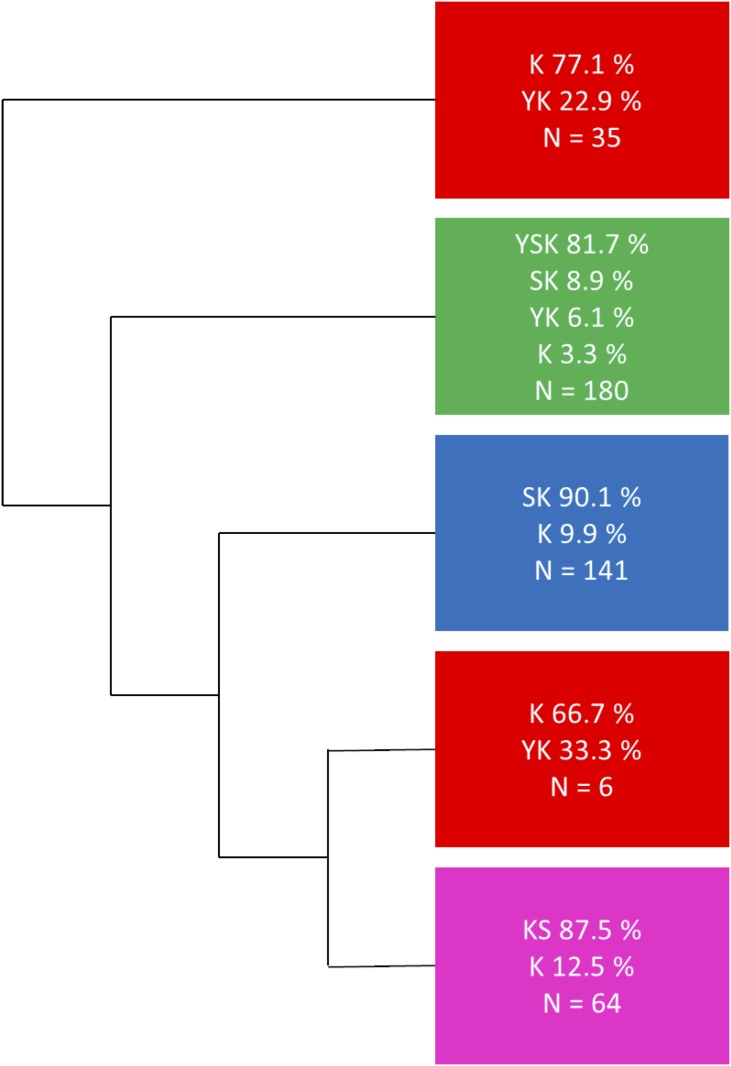
Simplified phylogenetic tree using reannotated sequences showing major dehydrin architecture clusters.The phylogenetic tree in S2 Fig was reduced into clusters by visual inspection in order to minimize the number of clusters while simultaneously trying to generate clusters that were enriched with just one architecture type. The colors represent the major architecture present in each cluster; red for Kn dehydrins, magenta for KnS dehydrins, blue for SKn dehydrins, and green for YnSKn dehydrins.